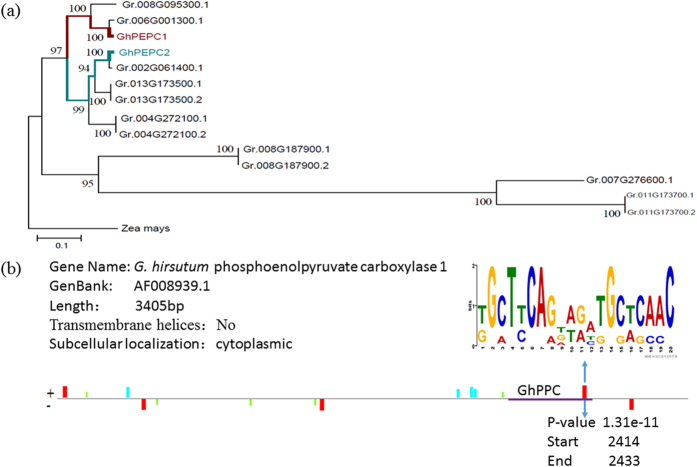
Phylogenetic analysis and comprehensive sequence information of GhPEPC1 gene.(a) A neighbor-joining rooted phylogenetic analysis of GhPEPCs using zea mays PEPC as outgroup. (b) Sequence information of GhPEPC1, including the conserved domain (defined as GhPPC).